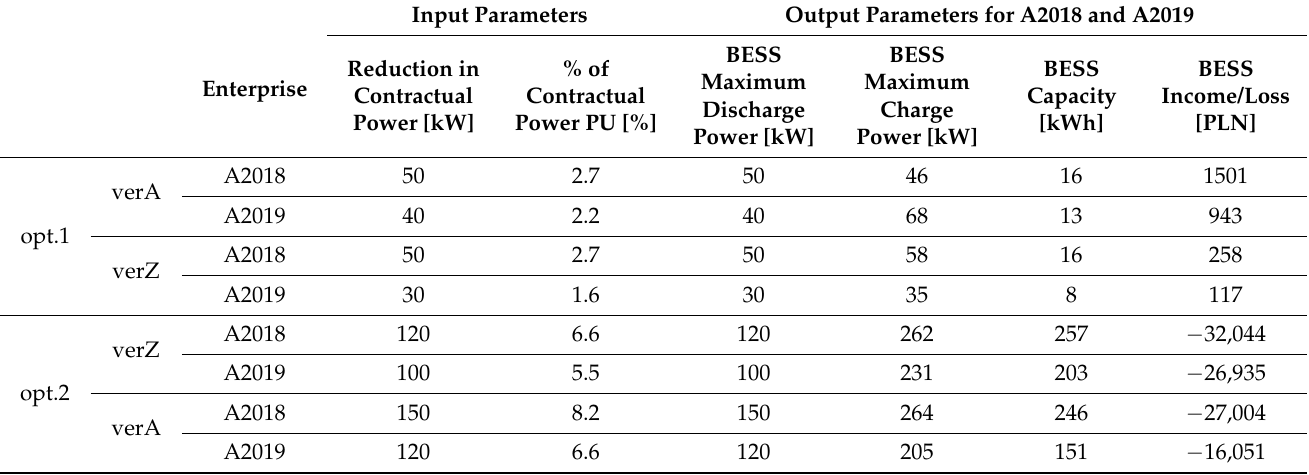
Table 3. Numerical results of the simulation of the peak shaving strategy for enterprise A in 2018 (A2018) and 2019